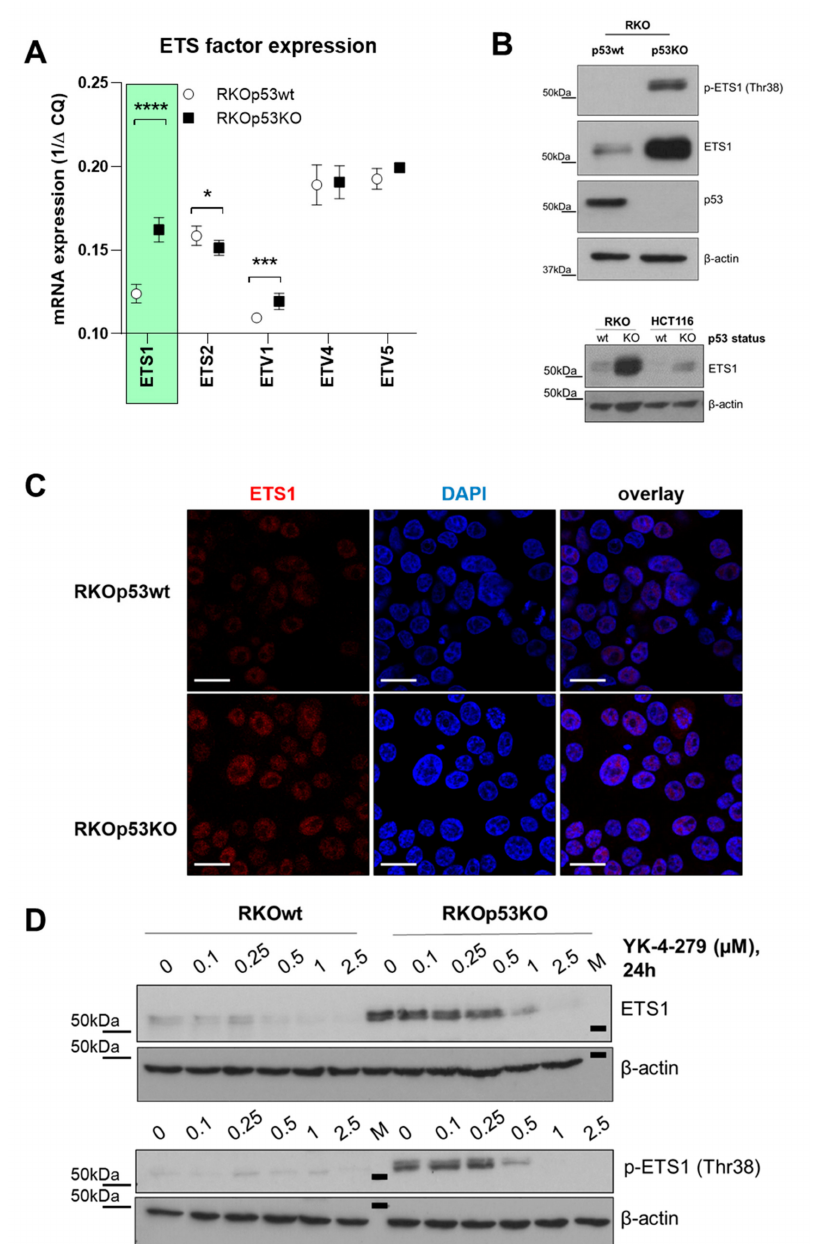
Figure 2. Expression / phosphorylation of ETS1 is increased in a p53 knock-out RKO colon cancer background. ( A ) mRNA expression levels of the indicated E26 transformation-specific ETS factors were assessed by qRT-PCR in the RKO cell model as indicated. Values were normalized to the housekeeping gene RPL-41 . Students t -test was used for testing statistical significance with * p < 0.05, *** p < 0.001, and **** p < 0.0001. ( B ) Expression of ETS1 in the indicated colon cancer cell models was detected by Western blot analysis of total protein extracts. In the upper panel, p53 expression levels are shown for background confirmation. ( C ) Subcellular localization of ETS1 (red) in RKOp53wt and RKOp53KO cells was determined by immunofluorescence staining. 4 (cid:48) ,6-Diamidino-2-phenylindole DAPI (blue) was used as nuclear counterstain. Representative fluorescence photomicrographs are shown. The scale bar indicates 20 µ m. ( D ) Impact of YK-4-279 on expression of total and phosphorylated (Thr38) ETS1 levels in RKOp53wt and RKOp53KO cells was detected by Western blot analysis. β -actin was used as loading